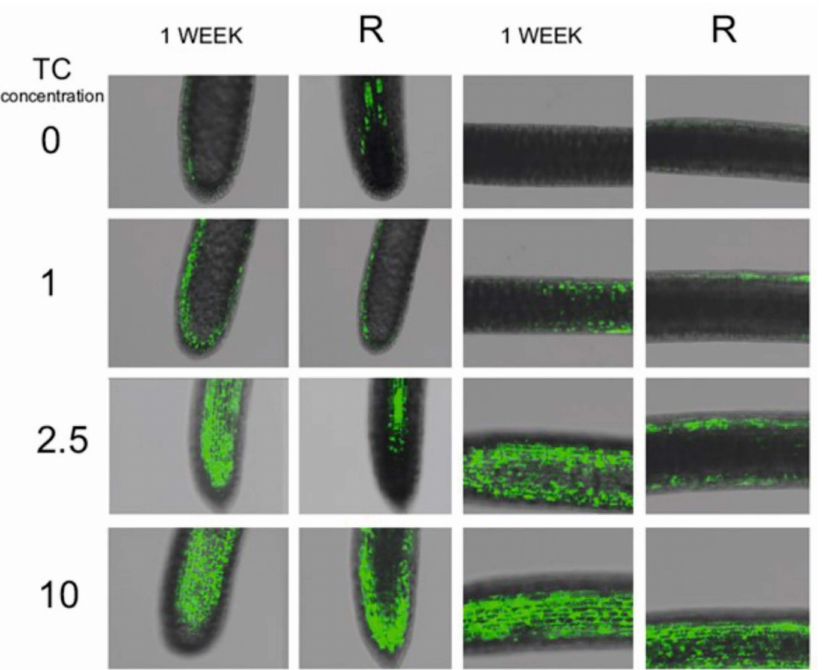
Figure 3. Free radicals (green colour) in roots (500 × ) of Lemna minor subjected to tetracycline (1 week) and in the recovery phase (R) (resumed growth after 7 days of culture in antibiotic-free medium). Similar results were obtained by Margas et al. [47], showing free radical accumulation in the roots of peas ( Pisum sativum L.) treated with tetracycline, as well as Orzoł et al. [54], in the root of yellow lupin treated with